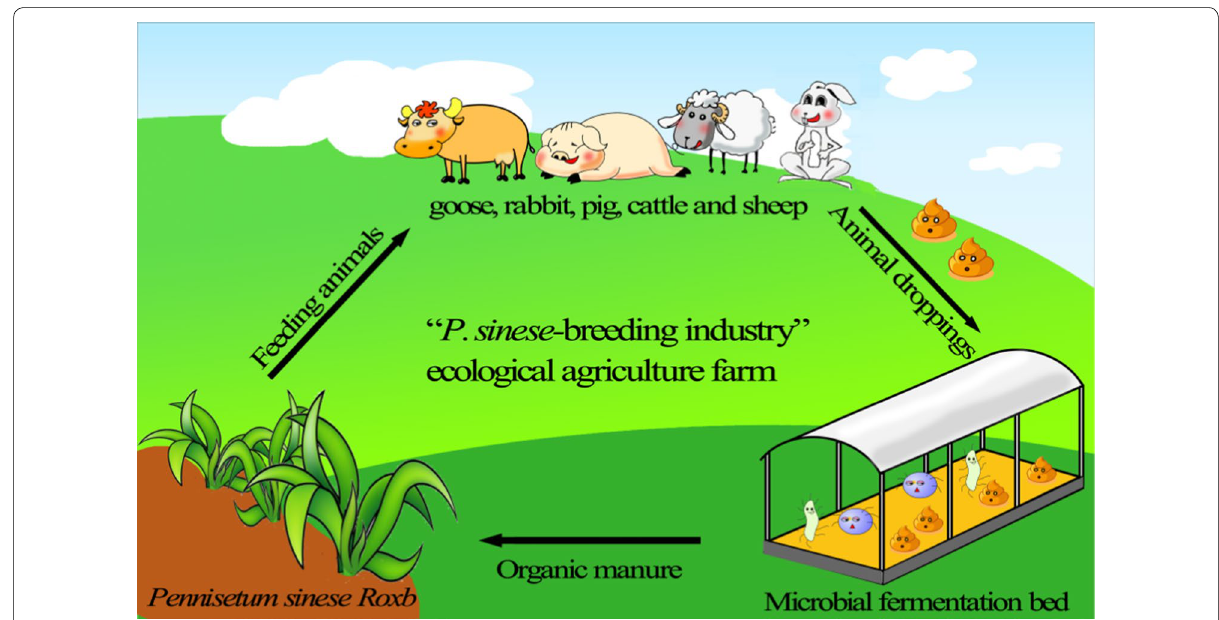
Fig. 1 Cartoon diagram of the“ Pennisetum sinese Roxb —breeding industry” “ P. sinses —breeding industry” ecological agriculture farm. The diagram was designed and drawn by Yan